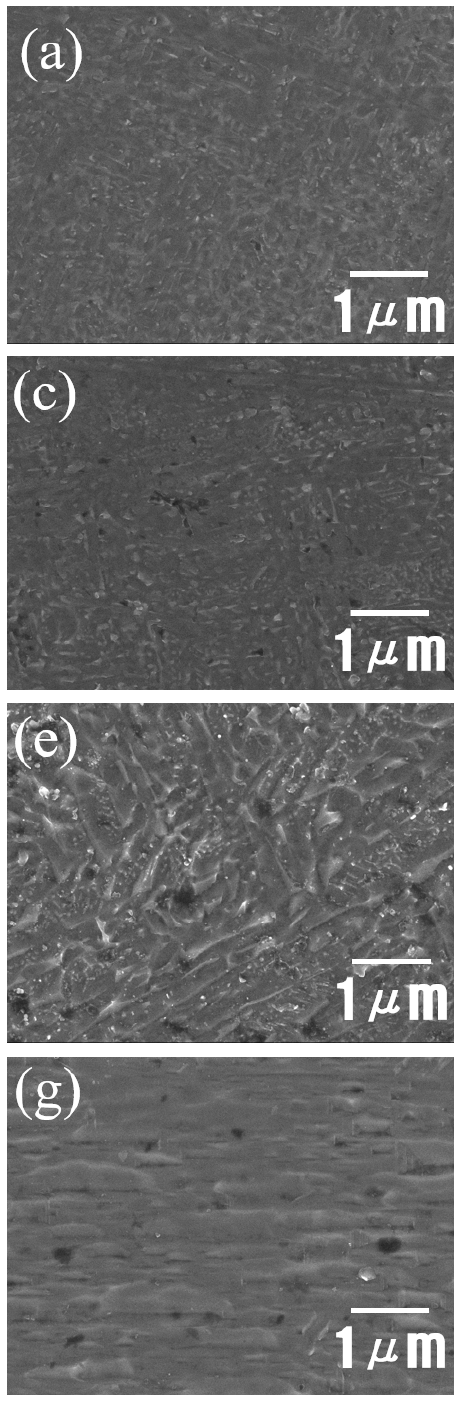
Figure 3. FE-SEM micrographs of the AM Ti–6Al–4V alloys: ( a ) as-received sample and heat-treated samples: ( b ) 650HT, ( c ) 650WQ, ( d ) 750HT, ( e ) 750WQ, ( f ) 850HT, and ( g ) 1000HT (HT: furnace cooling; WQ: water quenching).